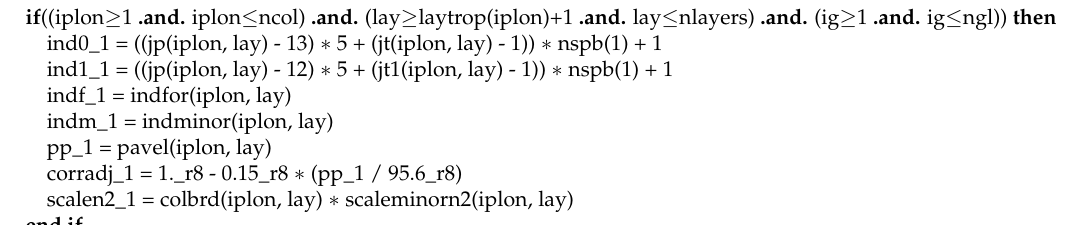
Table 3. A piece of code in taumol